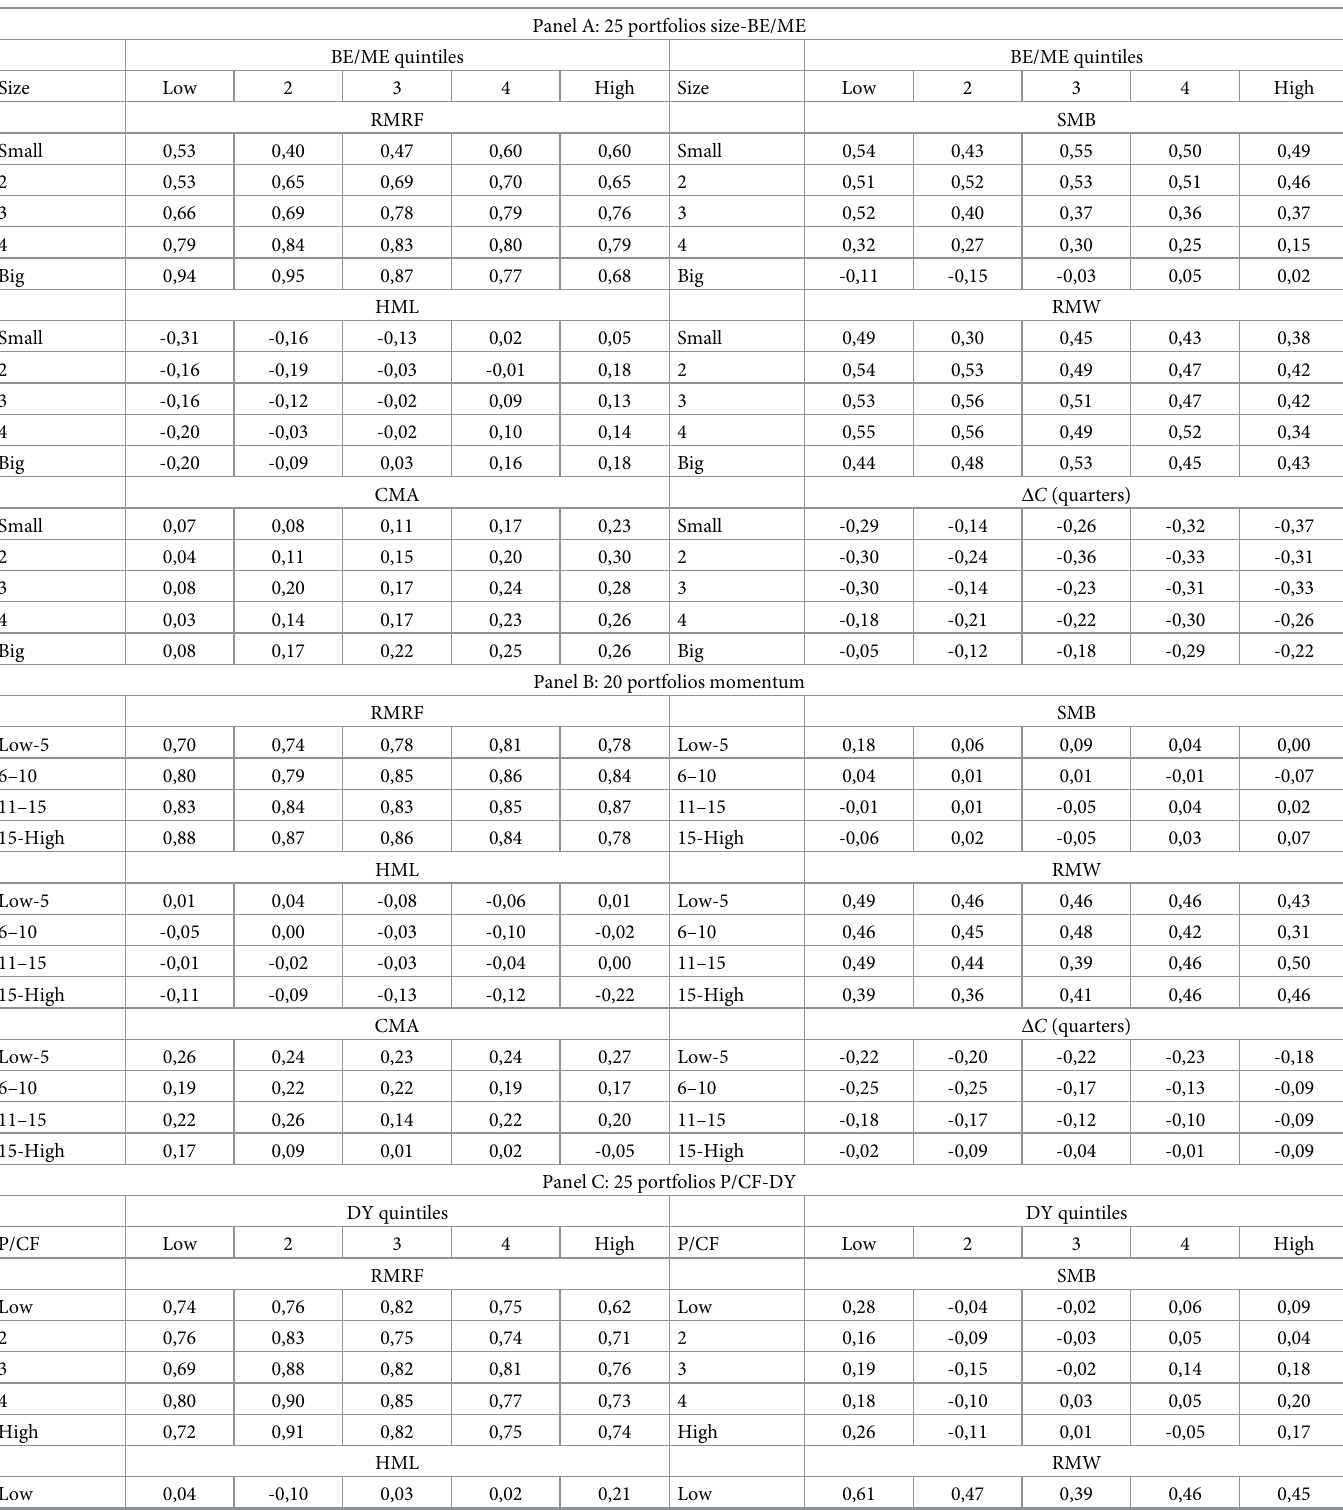
Table 2. Correlations.